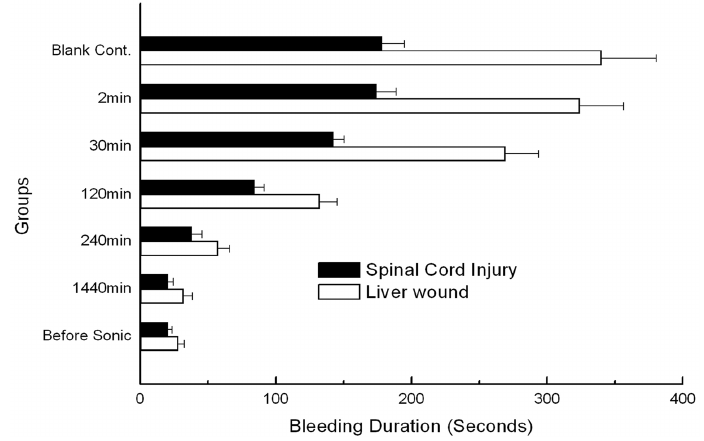
Figure 6. Time required for complete hemostasis. Graphs show the duration of bleeding in cases treated with 1% RADA16-1 self-assembling peptide solution relative to saline-treated samples (blank control group) in the case of spinal cord transection and liver sagittal cuts.